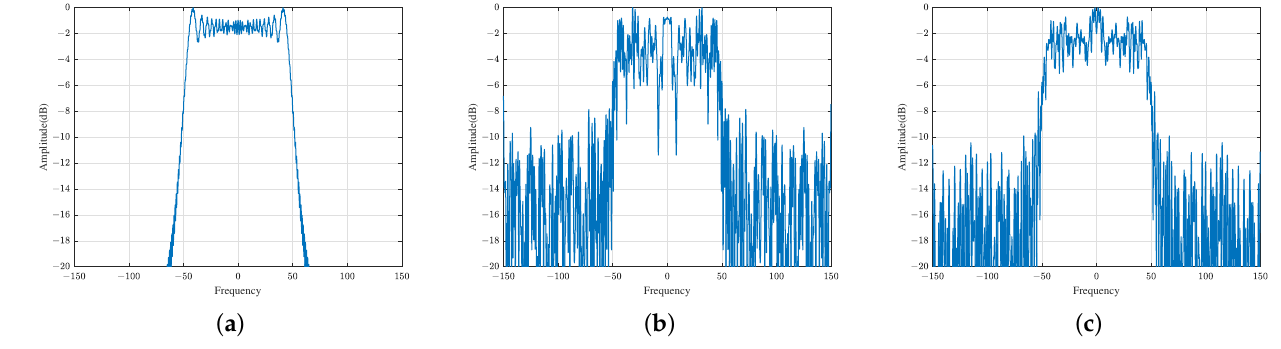
Figure 8. The spectrum of a wideband signal with a low oversampling rate set to 3. ( a ) Results with high-precision quantization. ( b ) Results with one-bit quantization. ( c ) Results with the proposed two-bit